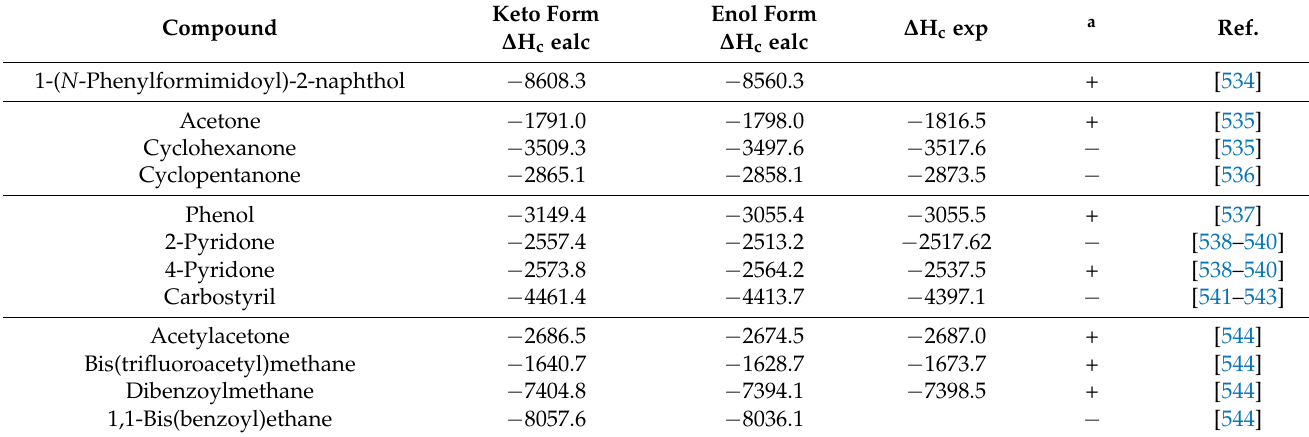
Table 7. Calculated and experimental ∆ H ◦ (c) (in kJ/mol) of Tautomeric Ketones and β -Diketones. Compound